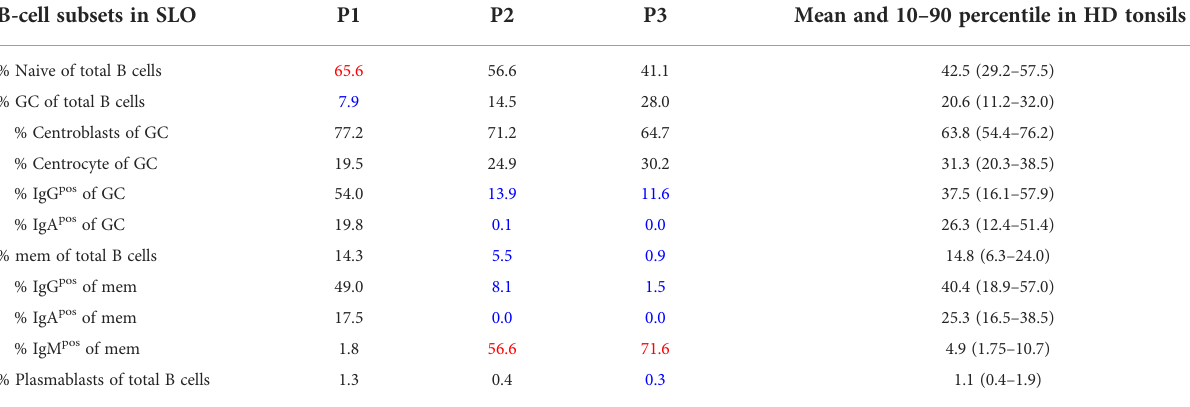
TABLE 2 Frequencies of B-cell subsets in